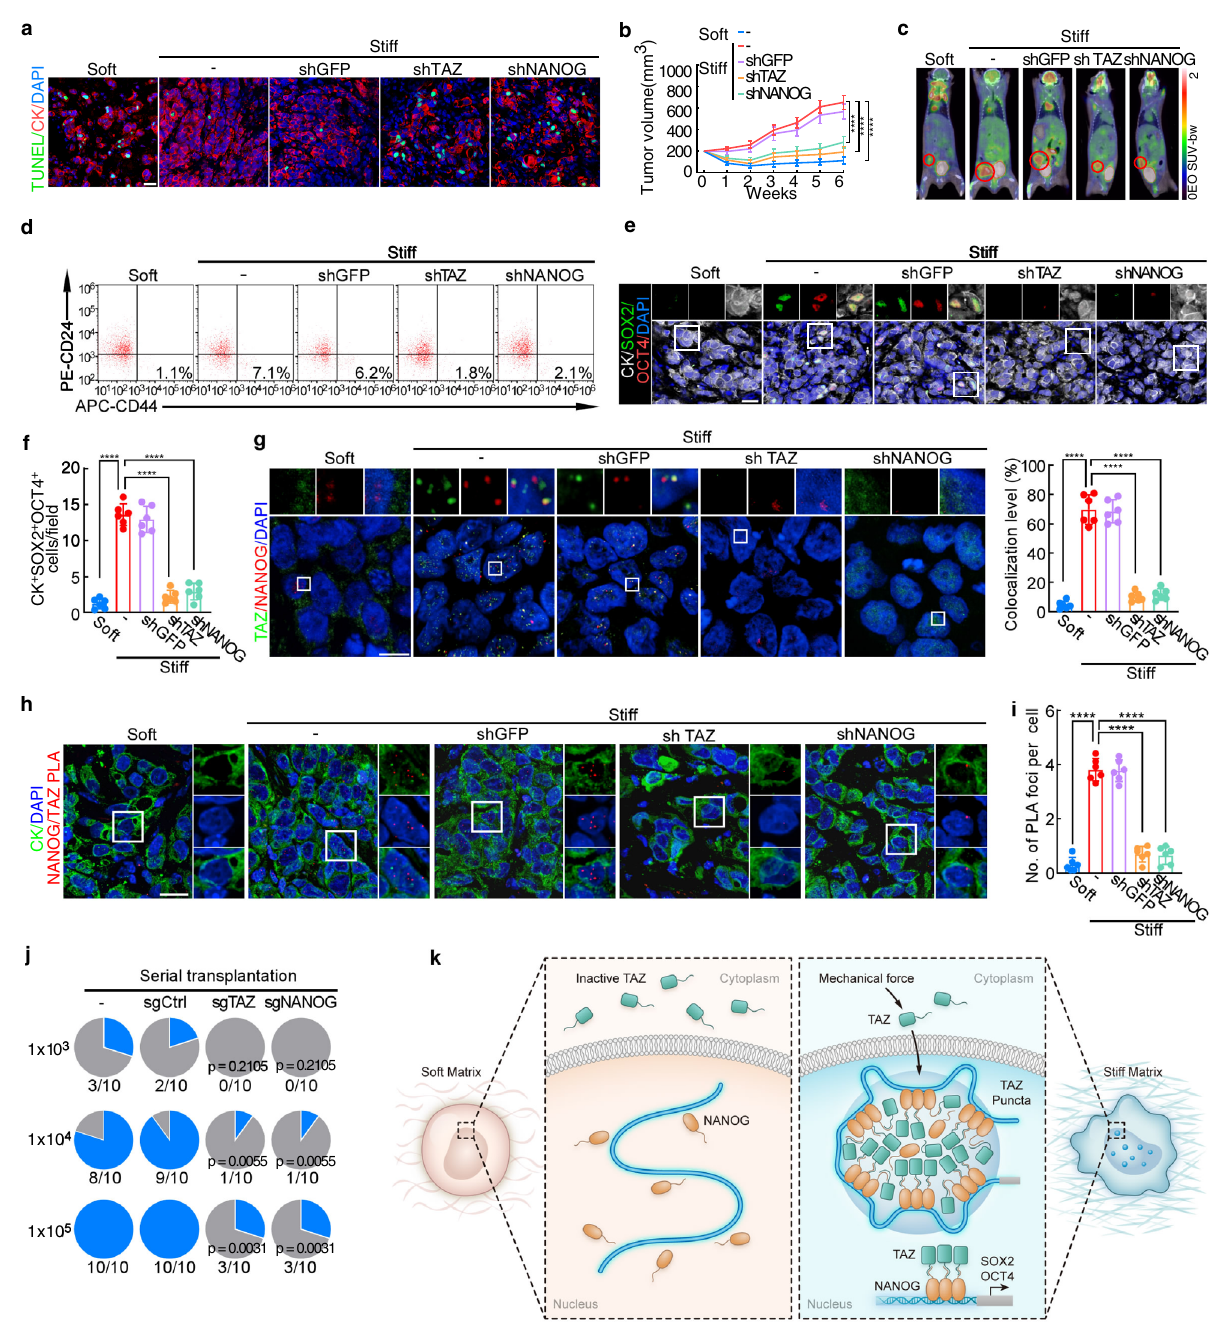
Fig.7|TAZandNANOGregulatecancerstemnessandchemoresistanceinvivo. a – h MCF-7 cells transduced with shGFP, shTAZ or shNANOG were mixed with hyaluronan-derived hydrogels and injected into the mammary fat pads of NOD/ SCID mice. Mice were treated with docetaxel (Doc) per week ( n =6 biologically independent animals per group). a Representative confocal images of TUNEL and CK in the harvested xenografts. Scale bars, 20 μ m. See also Supplementary Fig. 6a. b Tumor sizes of the indicated groups. c Representative images of tumor growth monitored by PET-CT after six weeks of treatment. Red circles indicate tumors. d Tumor cells were isolated from the harvested xenografts. The proportions of CD44 high CD24 low tumor cells were detected by fl ow cytometry. See also Supple- mentary Fig. 6b. e Representative confocal images for CK, SOX2, and OCT4 in the harvestedxenografts.White boxes indicate location of higher magni fi cationviews. Scale bars, 20 μ m. f Quanti fi cation of CK + SOX2 + OCT4 + cells in Fig.7e. g (Left)